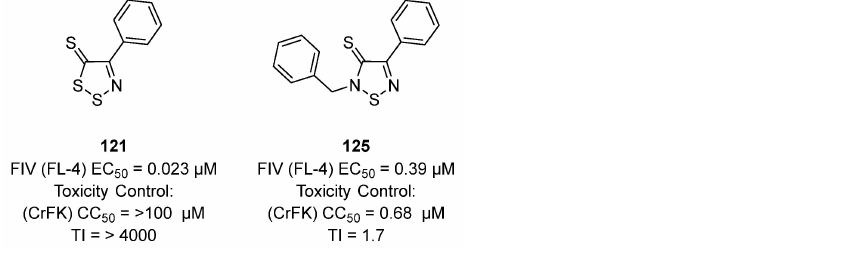
Figure 23. Direct comparison of 121 against 125 with the disrupted 1,2,5-thiadiazole-3(2 H )-thione ring